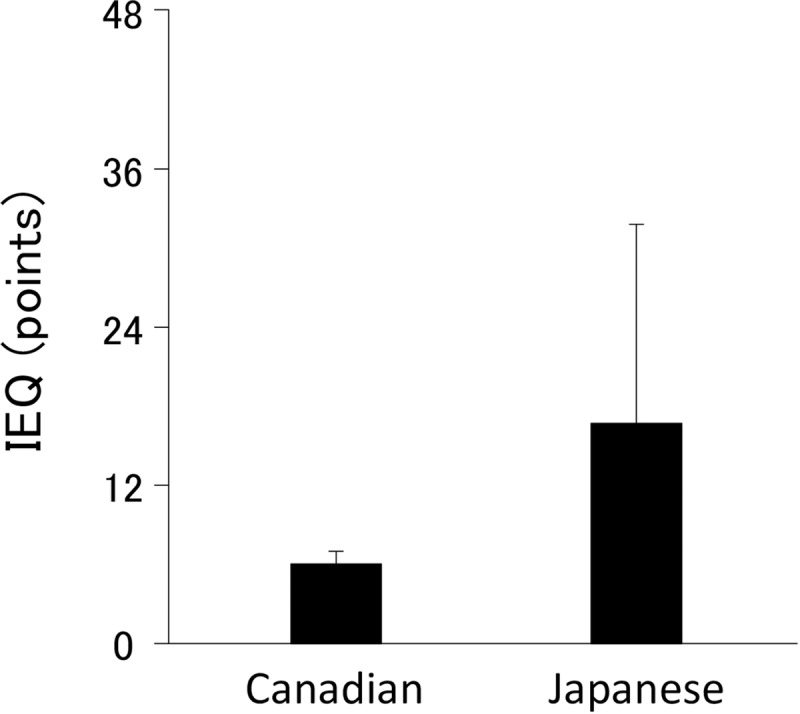
IEQ scores at before treatment.All graphs plotted the mean ± the SD of the mean. The IEQ mean scores of the Japanese sample were 2 points above the SD when compared to the mean scores of the Canadian sample. IEQ, Injustice Experience Questionnaire.